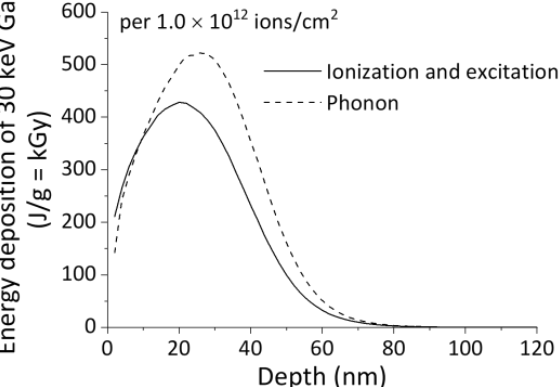
Figure 1. Energy deposition of 30 keV Ga + focused ion beam (FIB) in poly(L-lactic acid) (PLLA) per 1.0 × 10 12 ions/cm 2 .